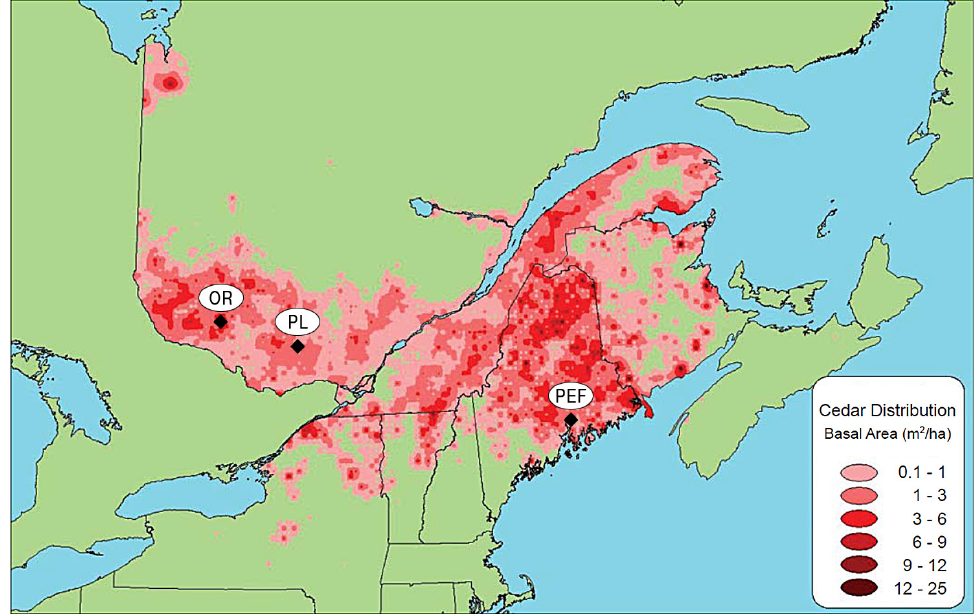
Figure 1. Location of the 3 study sites showing the northern white-cedar basal area in Quebec, Atlantic provinces, and northeastern United-States: Outaouais Region (OR), Papineau-Labelle wildlife reserve (PL), Penobscot Experimental Forest (PEF). Reproduced with permission from Éric Forget, Nova Sylva